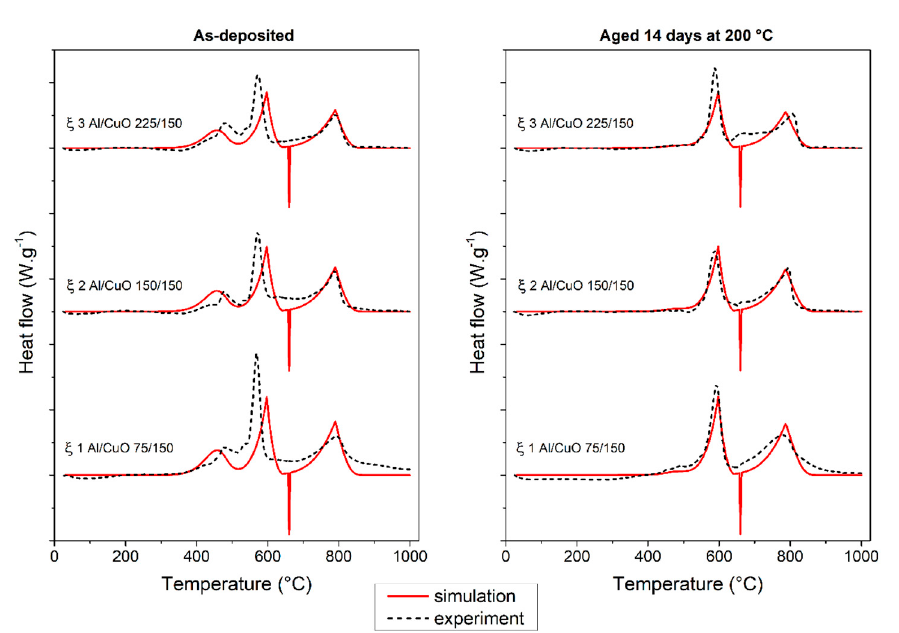
Figure 4. Experimental and theoretical DSC curves of Al/CuO nanolaminates: (left column) as-deposited and (right column) being aged 14 days at 200 °C.